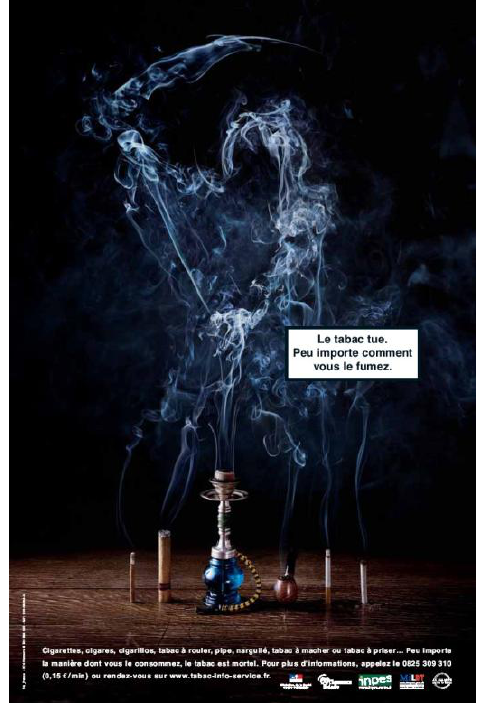
Figure 2. Poster of the French INPES (Institut National pour la Prevention et l‟Education a la Santé). This visual aid was used duri ng the 2005 “World No Tobacco Day” campaign sponsored by the WHO. It shows a huge cloud of dense smoke (supposedly ETS) stemming from a hookah and featuring the spectrum of